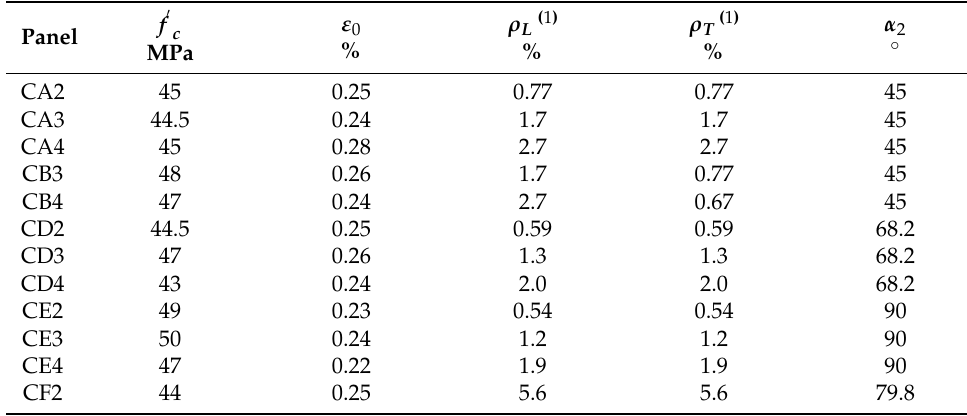
Table 1. Main properties of the reference reinforced concrete (RC) panels